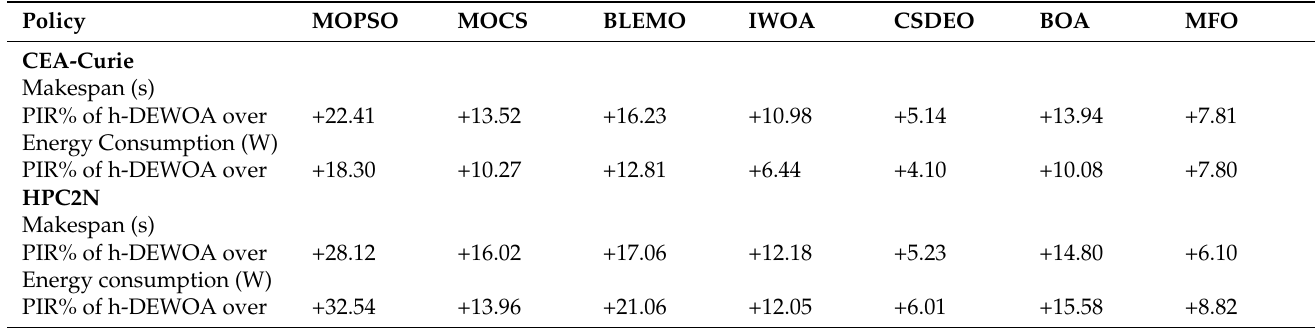
Table 19. PIR% of the h-DEWOA over comparative algorithms for the second set of experiments.